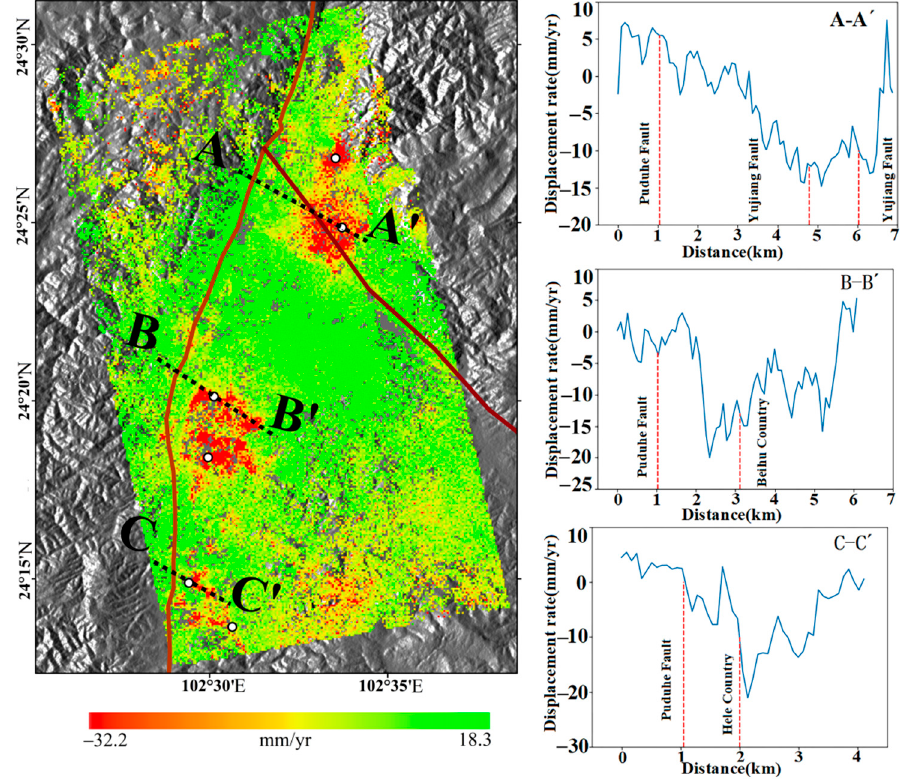
Figure 12. Deformation profiles of the existing fault zone near the subsidence area (AA’, BB’, and C-C’ shown in this figure).